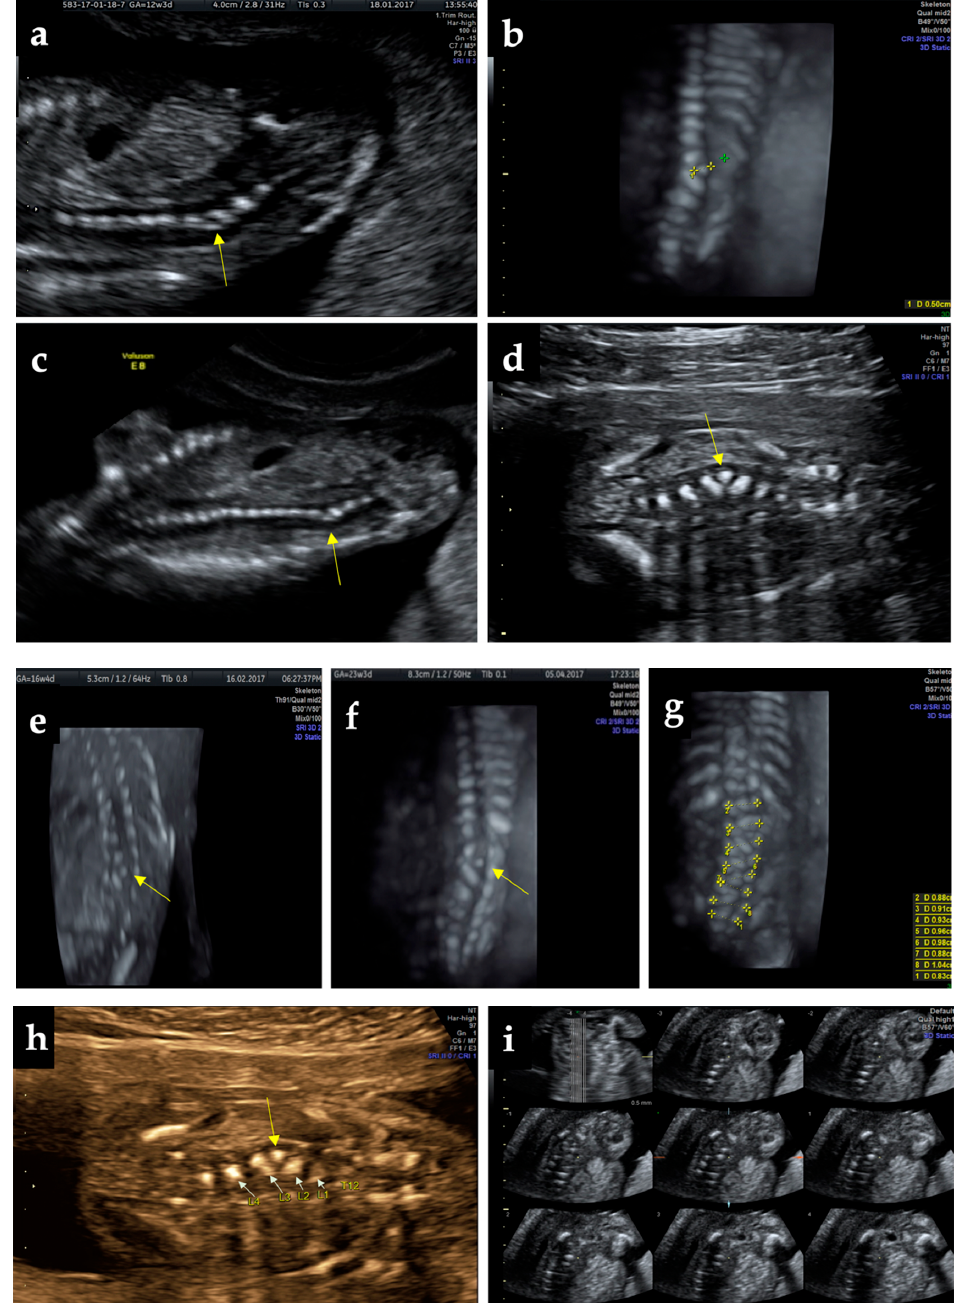
Figure 1. Ultrasound findings: ( a ) suspect angulation of the thoracolumbar spine at 12-weeks show the hemivertebrae (yellow arrow), ( b ) zoom-in above the hemivertebrae in 3D static reconstruction, ( c ) image of the whole spine at 12-weeks; ( d ) clear 2D imaging of the hemivertebrae; ( e , f )—US scans of the fetal spine at 16 and 23 weeks, ( g ) tracing the correspondence of the vertebrae lateral ossification centers, ( h ) numbering and positioning of the vertebrae at 23 weeks on 2D ultrasound sepia mode, ( i ) Tomographic Ultrasound Imaging (TUI)—successive scans of the spine revealing the anomaly. At 38 weeks of gestation, in the context of the spontaneous onset of labor and sponta- neous ruptures of the fetal membranes, an apparently healthy male fetus weighing 2350 g, 46 cm, Apgar score 9 was extracted through cesarean